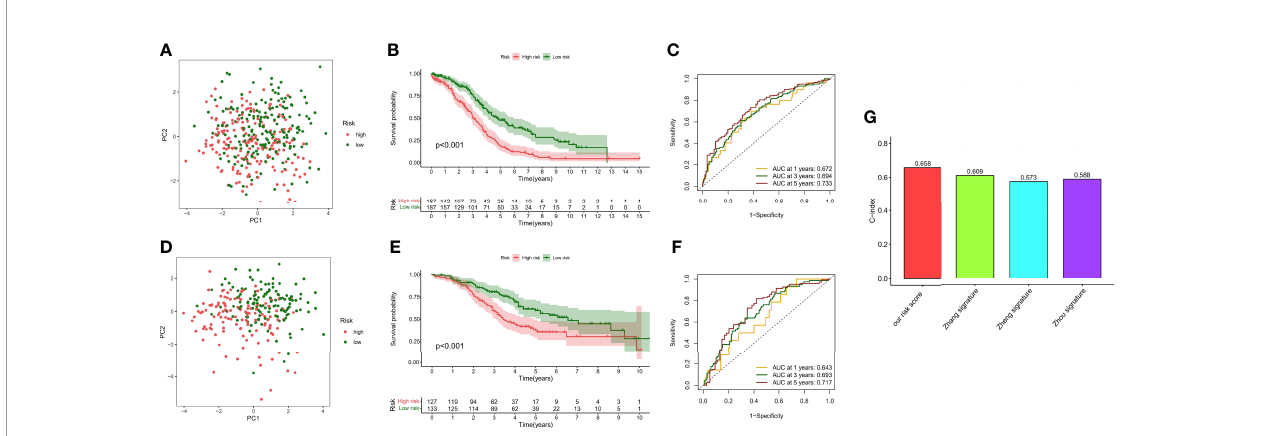
FIGURE 7 | Survival analysis and model comparison of the hypoxia risk score. (A) PCA analysis in the TCGA cohort. (B) Kaplan – Meier analysis of different risk groups in the TCGA cohort. (C) ROC curve of the 1-, 3-, and 5-year survival prediction in the TCGA cohort. (D) PCA analysis in the GEO cohort. (E) Kaplan – Meier analysis of different risk groups in the GEO cohort. (F) ROC curve of the 1-, 3-, and 5-year survival prediction in the GEO cohort. (G) C-index of different risk